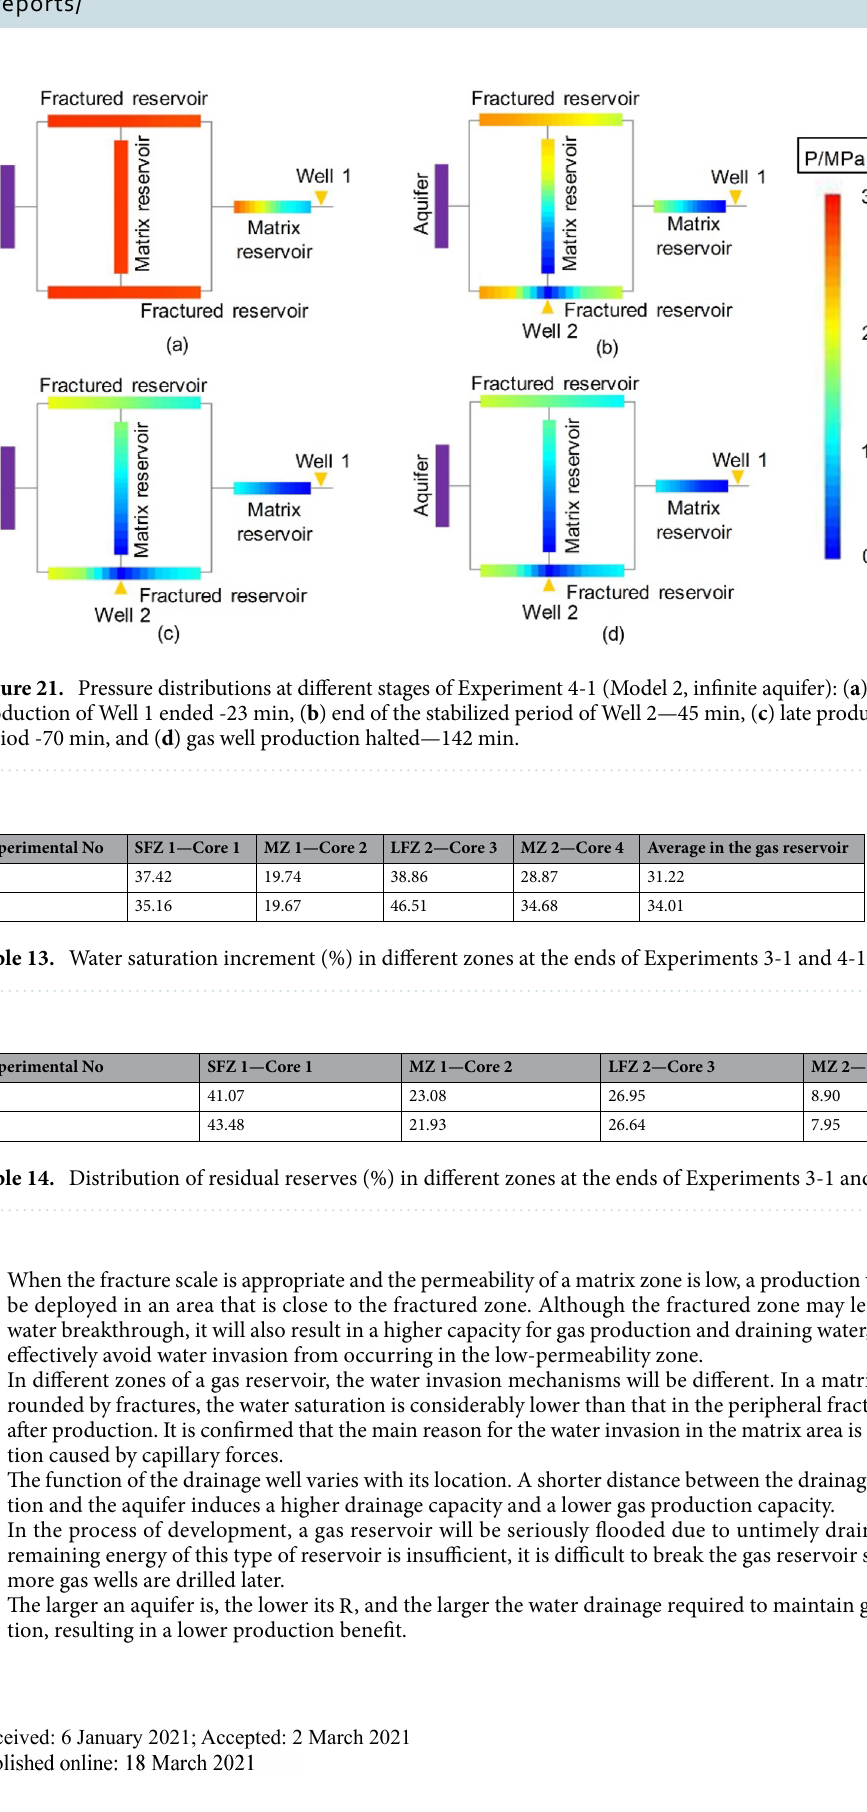
Table 14. Distribution of residual reserves (%) in different zones at the ends of Experiments 3-1 and 4-1.